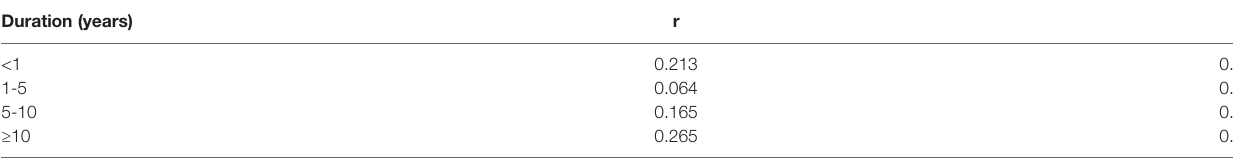
r, correlation coef fi cient.